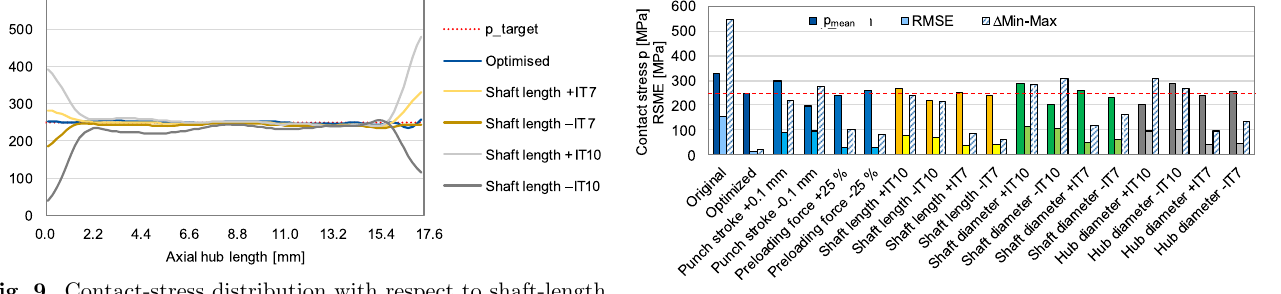
Fig. 11. Comparison of mean contact stress and RSME for geometric and machine-related